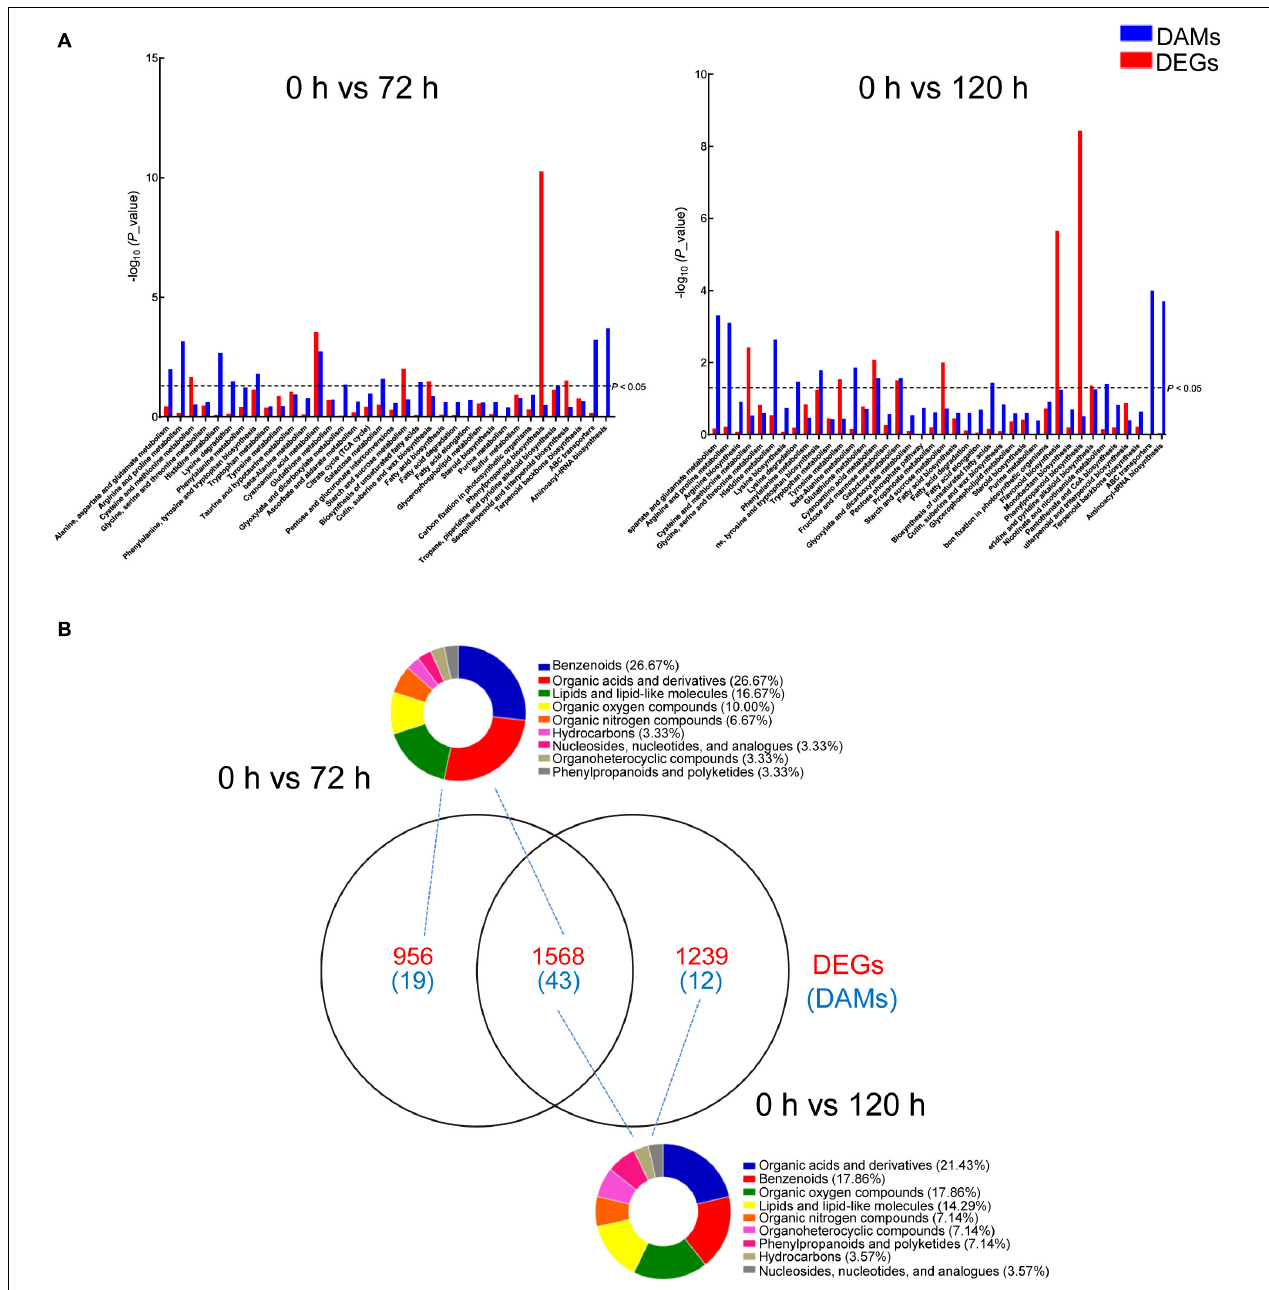
FIGURE 7 | Analysis of DAMs and DEGs in peach roots under BA stress. (A) KEGG enrichment analysis of DAMs (blue) and DEGs (red) that are correlated with each other. The x -axis represents KEGG pathway subcategories. (B) Venn diagram analysis of DEGs (red) and DAMs (blue) in two compared combinations. The DAMs identified from two compared combinations (0 h vs. 72 h and 0 h vs. 120 h) were classified using the Human Metabolome Database (HMDB). The pie graphs represent the classification results, and the different colors represent different compounds